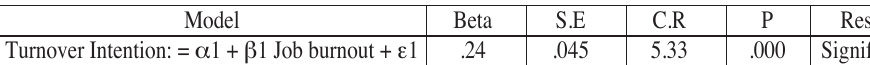
Job Burnout and Turnover Intention